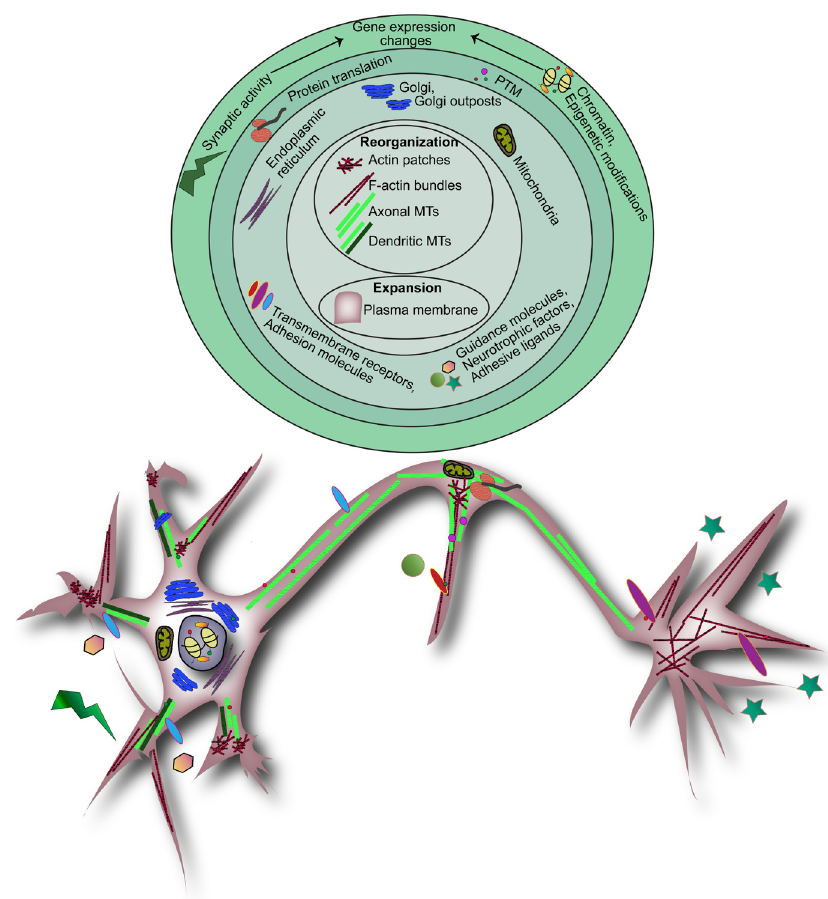
Figure 1. Hierarchical events of neuronal branching. Neuronal branching is a coordinated process that requires extensive filamentous actin and microtubule (MT) reorganization and plasma membrane expansion, depicted in the center of the branching hierarchy. These foundational events are spatially and temporally regulated by numerous signaling and mechanical pathways in a coordinated fashion. These pathways are initiated in response to synaptic activity, extracellular guidance molecules, neurotrophic factors, or adhesive ligands. This outside-in signaling results in extensive cytoskeletal and membrane changes regulated directly through signal transduction, transport and sorting of organelles and cargo-carrying vesicles, and energy production or indirectly through gene expression changes via transcriptional regulation, epigenetic modifications, post-transcriptional and post-translational modifications (PTMs), and local protein